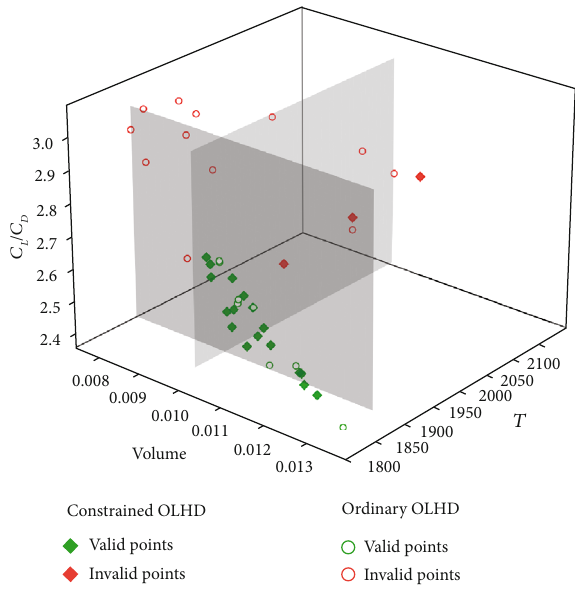
Figure 5: Comparison of DoE